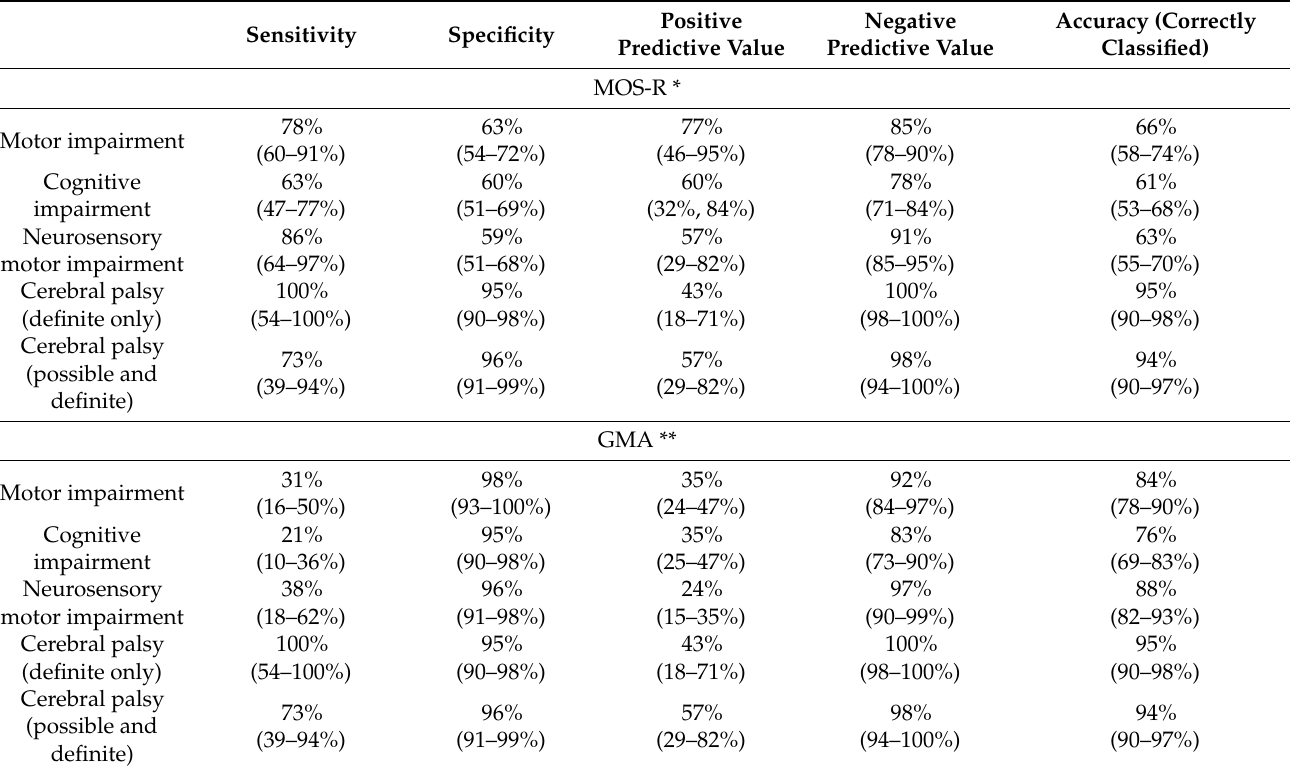
Table 4. Diagnostic statistics for MOS-R optimal cut-off and GMA with motor, cognitive, or neurosen- sory motor